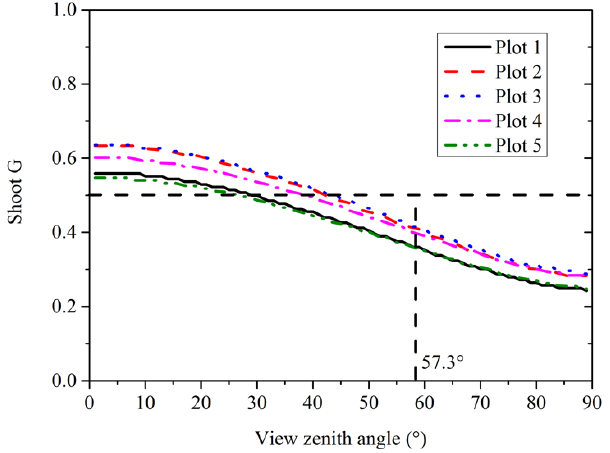
Figure 9. Derived whole-canopy shoot projection function against viewed zenith angles in the five plots in 2017.